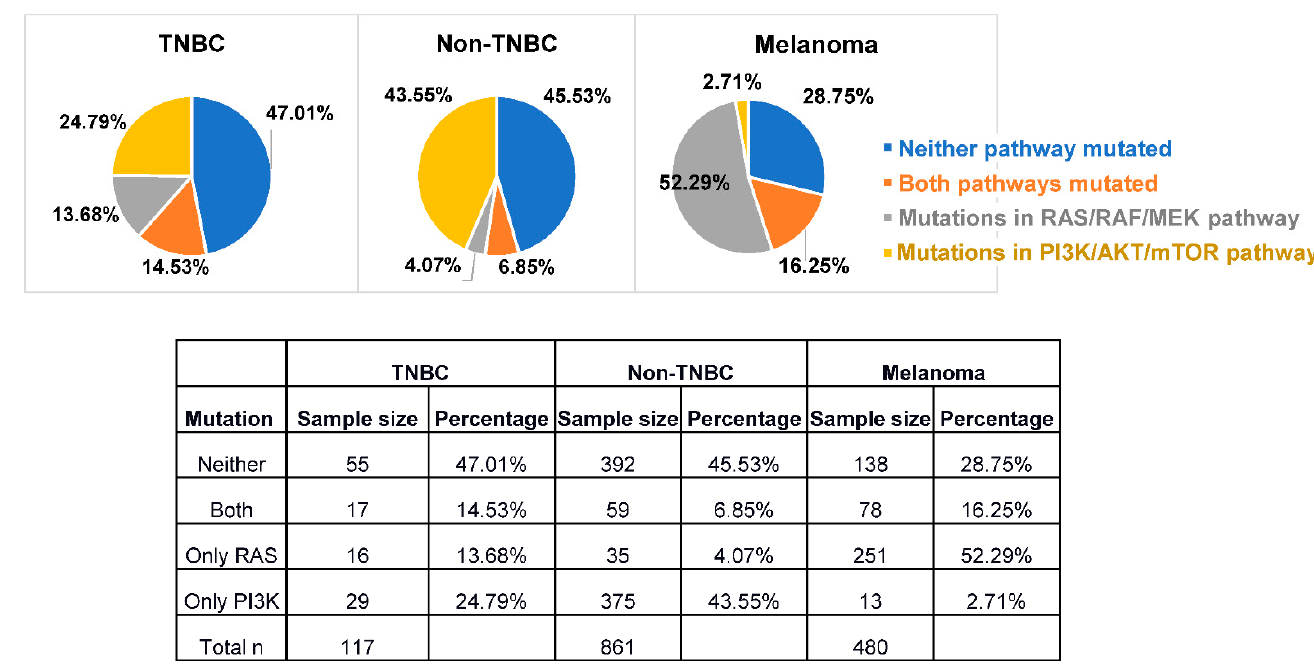
Figure 1. Percentage of TNBC, non-TNBC, and melanoma patients with mutations in the PI3K and MAPK pathways. Mutations in each pathway were identified as somatic genetic variant in at least one gene from the PI3K pathway ( PTEN, PIK3CA, AKT1, ERBB2, PIK3R1 ) or RAS pathway ( HRAS, KRAS, NRAS, BRAF, NF1, and SOS1 ). TNBC, triple-negative breast cancer.